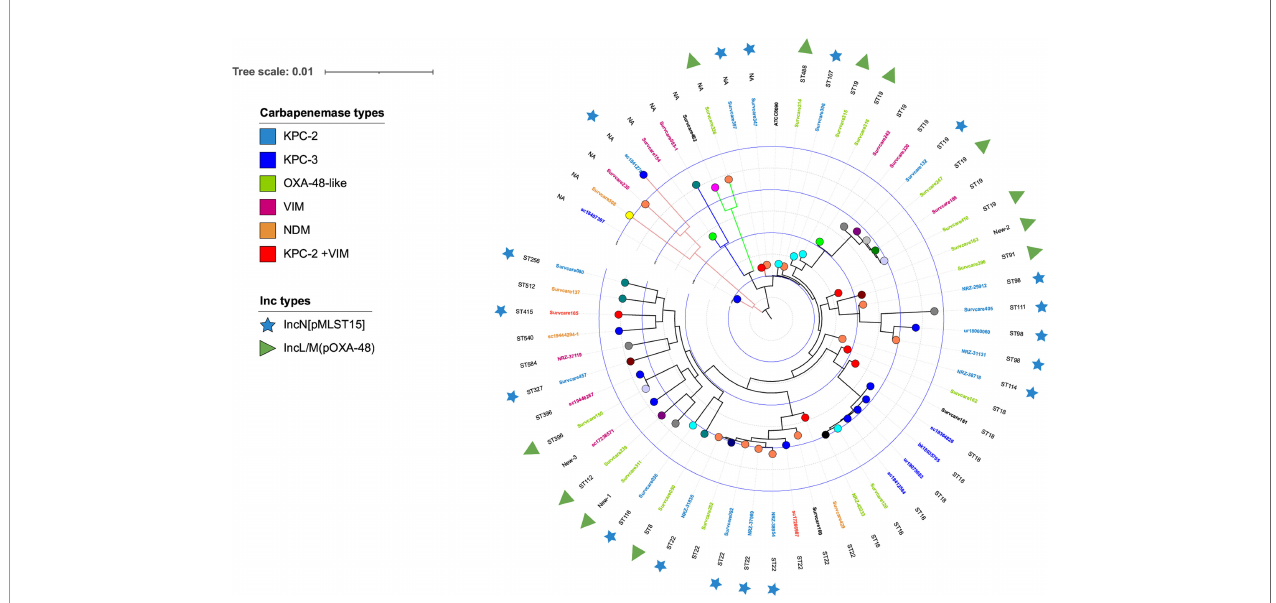
FIGURE 1 | Phylogenetic tree of the 56 sequenced Citrobacter spp. isolates based on SNPs-analysis with the C. freundii strain ATCC 8090 (Access No. BBMV01000001) as reference genome, generated and annotated with the iTOL tool (https://itol.embl.de/tree/) (Letunic and Bork, 2021). The bacterial species is displayed with different branch line colors: C. freundii , black, C. portucalensis , orange, C. europaeus , blue, C. braakii , green, and C. koseri , red. The hospitals, from which the isolates were obtained, are indicated with the 16 different colored circles on the tree nodes. The different identi fi ed carbapenemase types are marked with different colors according to the isolate labels. ST, C. freundii MLST types of the C. freundii isolates. IncN[pMLST15]: the bla KPC-2 gene-carrying plasmid are represented by an asterisk in the KPC-2 carbapenemase-producing isolates. IncL/M( pOXA-48 ): the Inc type of plasmids identi fi ed in the OXA-48-like carbapenemase-positive isolates and likely to carry their bla OXA-48 or bla OXA-162